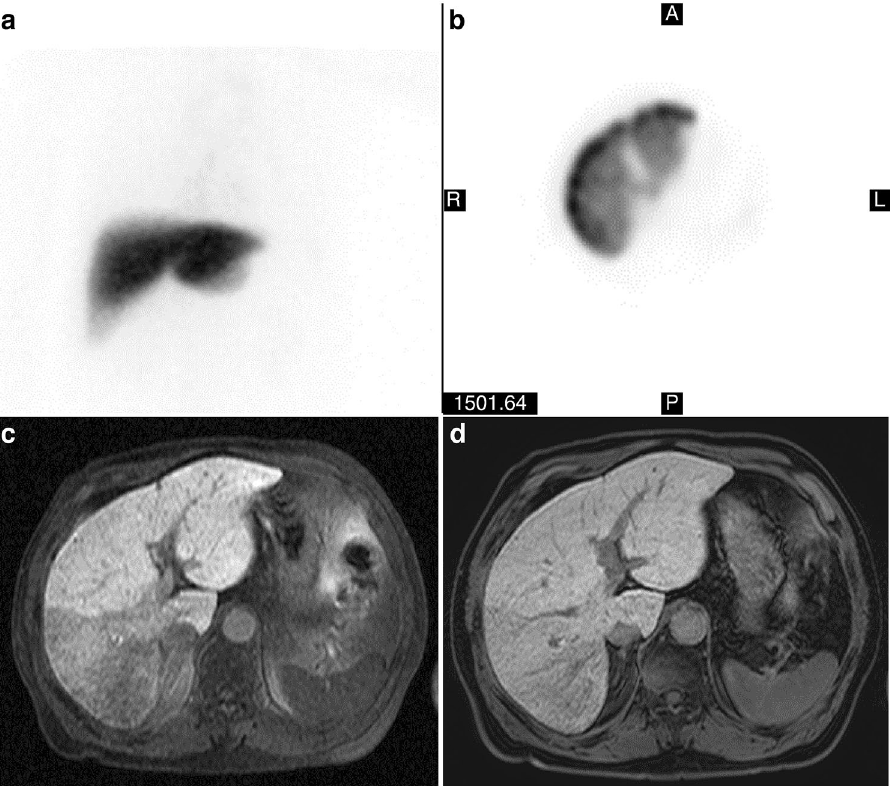
Figure 1. Comparison of 99m Tc-GSA liver scintigraphy and Gd-EOB-DTPA-enhanced MRI. ( a ) Planar image of 99m Tc-GSA liver scintigraphy. ( b ) Transverse image of 99m Tc-GSA liver scintigraphy. It is impossible to distinguish hepatic segments from this image because intrahepatic portal vein and hepatic vein were not imaged. ( c ) Gd-EOB-DTPA-enhanced MRI with a built-in body coil. A decrease in signal intensities in right posterior segments was clearly imaged, which is not found in (a,b) images. ( d ) Gd-EOB-DTPA-enhanced MRI with a 32ch phased array coil. The contrasts between right anterior and posterior segments decreased compared with the (c)